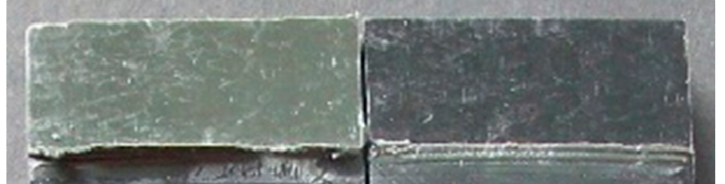
Figure 14. Fracture surface of a specimen pretreated with APPT with D = 10 mm and v = 200 mm/s and subjected to the quasi-static tensile test.